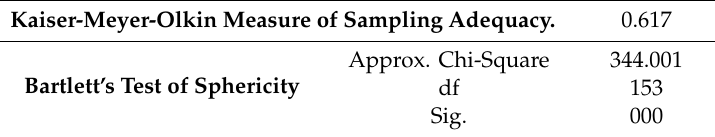
Table 2. KMO and Bartlett’s test.